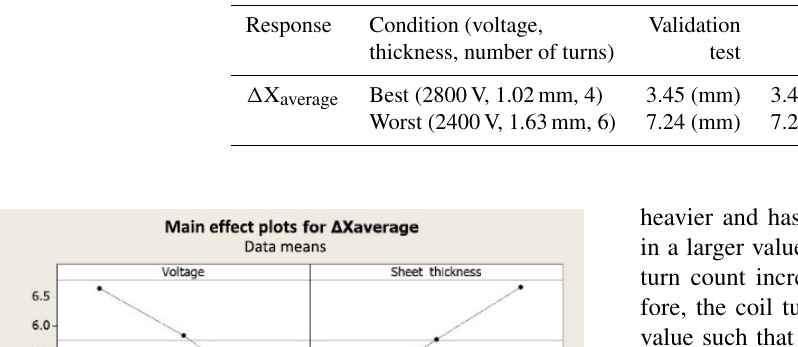
Figure 18. Difference between maximum values of point (a, b, c) for condition 8 (V = 2800volts, thickness = 1.22mm and N = 6). Table 6. Comparison of validation test results with initial runs.